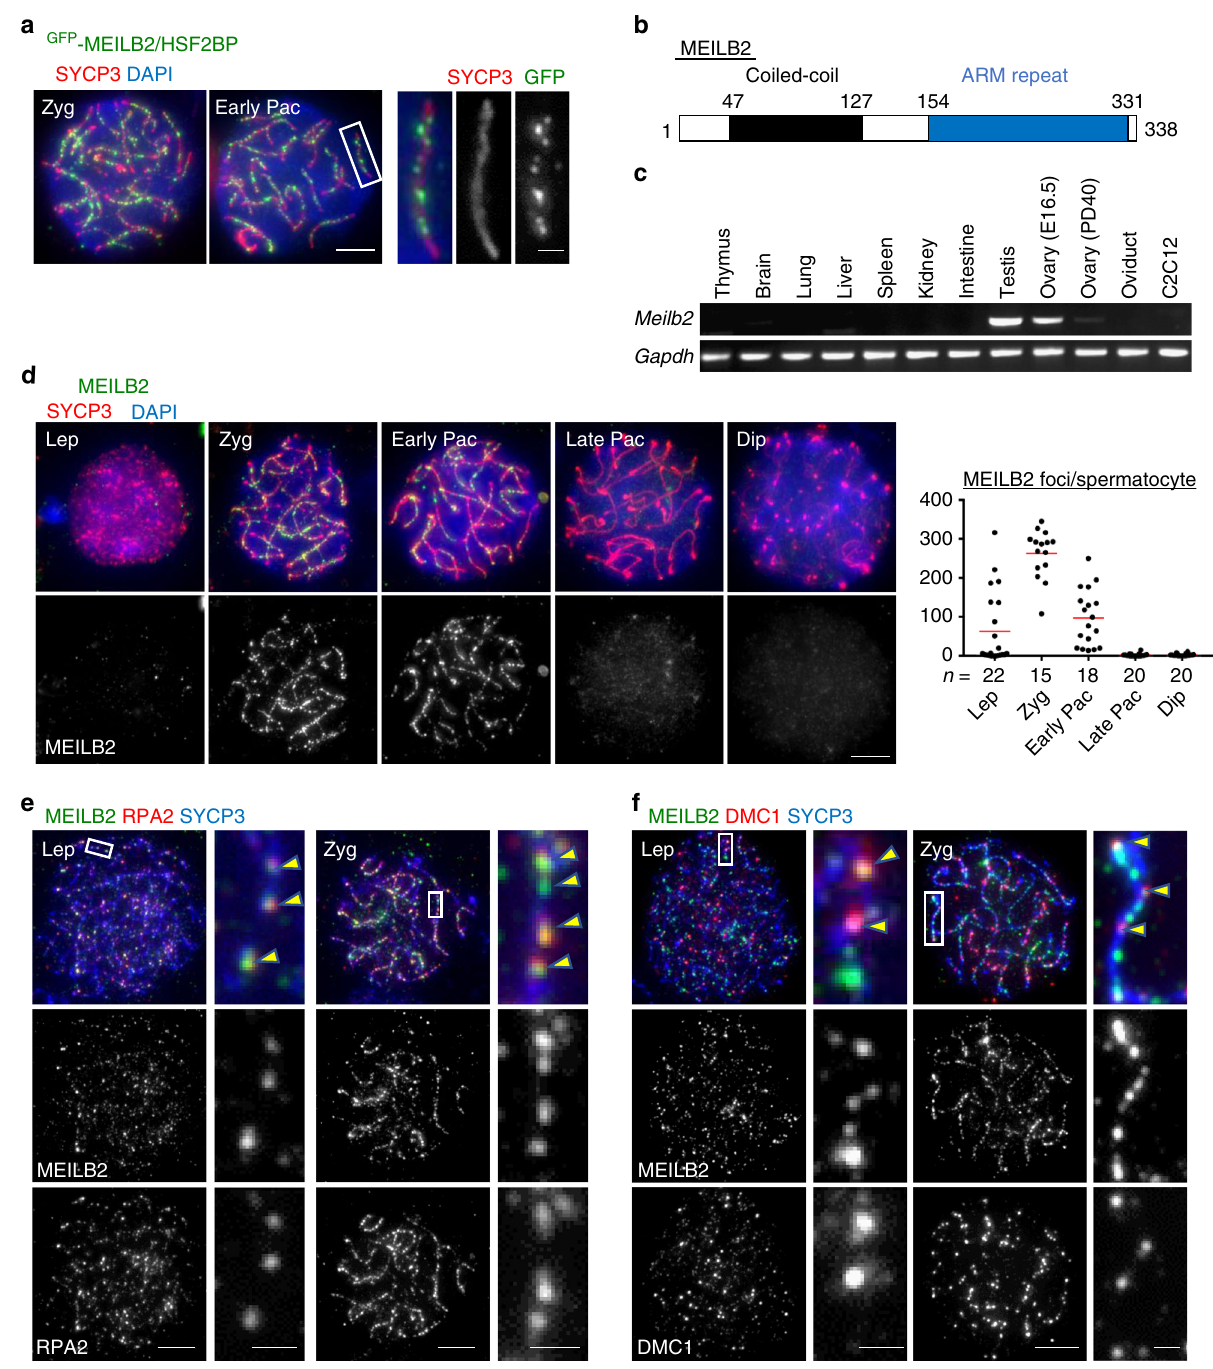
Fig. 1 Identi fi cation of MEILB2 as a meiotic chromosomal protein. a Wild-type (WT) spermatocytes expressing GFP-MEILB2/HSF2BP stained with the indicated antibodies and 4,6-diamidino-2-phenylindole (DAPI). b The domain conformation of MEILB2. The coiled-coil domain (a.a. 47 – 127) and armadillo (ARM) repeat domain (a.a. 154 – 331) are shown. c Tissue-speci fi c expression levels of Meilb2 and Gapdh (a loading control). C2C12 is a mitotically rounding cancer cell line. d WT spermatocytes stained with the indicated antibodies and DAPI. Each meiotic prophase I substage is shown. The graph shows the number of MEILB2 foci associated with the chromosome axes. The mean value is shown as a red bar. n shows the analyzed spermatocyte number pooled from two mice. Lep leptotene (dotty or discontinuous SYCP3), Zyg zygotene (linear SYCP3 with partial synapsis), Pac pachytene (Early; linear SYCP3 with complete synapsis and Late; linear SYCP3 with complete synapsis and thickened SYCP3 ends), Dip diplotene (linear SYCP3 with desynapsis). e , f WT spermatocytes stained with the indicated antibodies and DAPI. The co-localizing foci along the chromosome axis are highlighted by yellow arrowheads. The quanti fi cation of co-localization was performed using three late leptotene cells and six zygotene cells pooled from two mice for RPA2 ( e ) and six late leptotene cells and ten zygotene cells pooled from three mice for DMC1 ( f ). The axis-associated foci are counted. Scale bars, 5 and 1 μ m (magni fi ed panel). Source data are provided as a Source Data fi